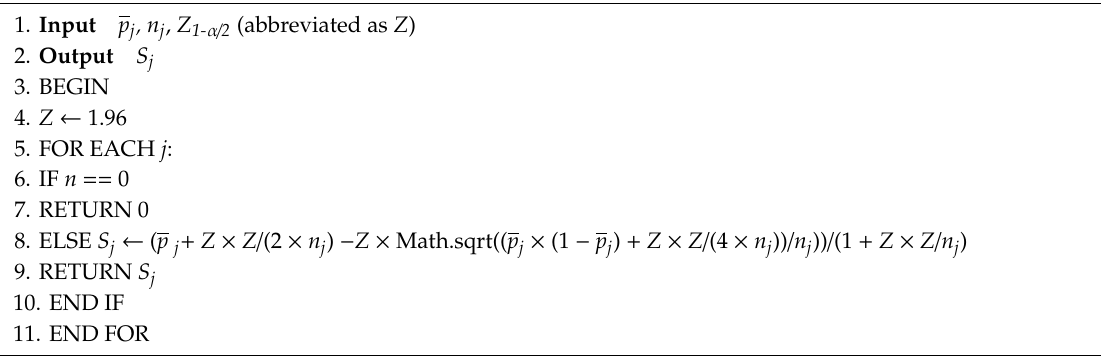
Algorithm 1: Lower bound of the Wilson score confidence interval